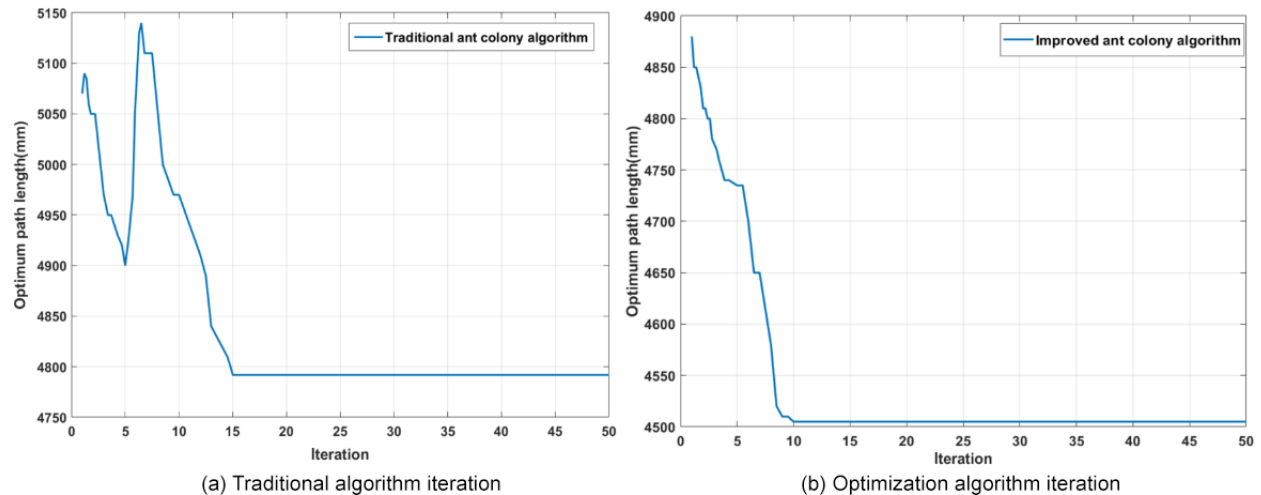
Figure 12. Iterative comparison process between traditional ant colony algorithm and improved ant colony algorithm.